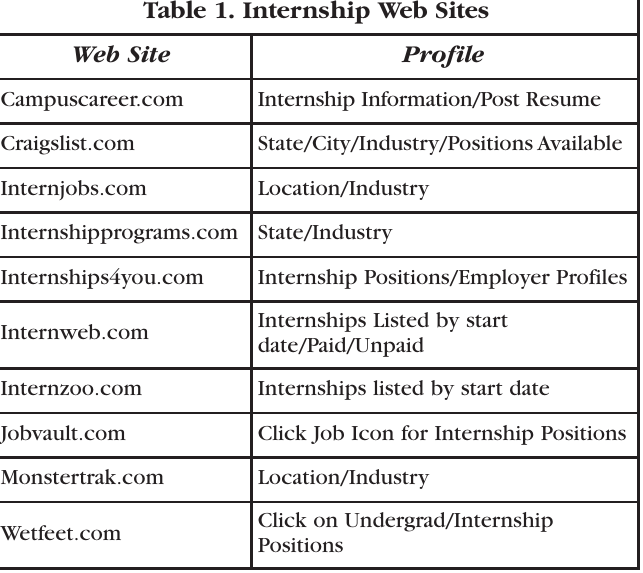
Table 1. Internship Web